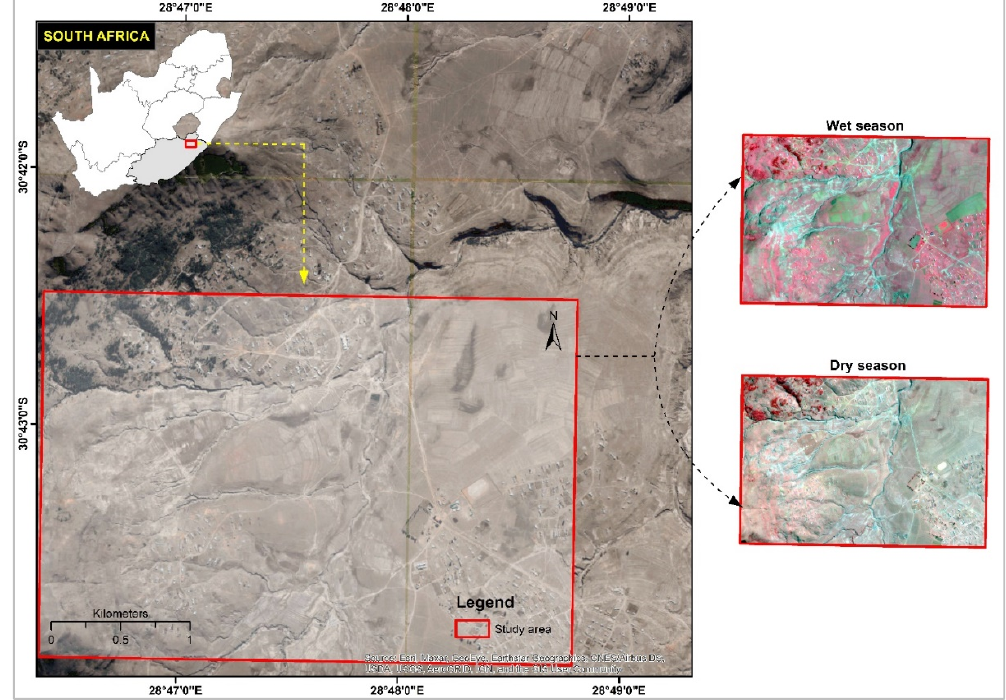
Figure 1. Location of the study area (PlanetScope false-color images).